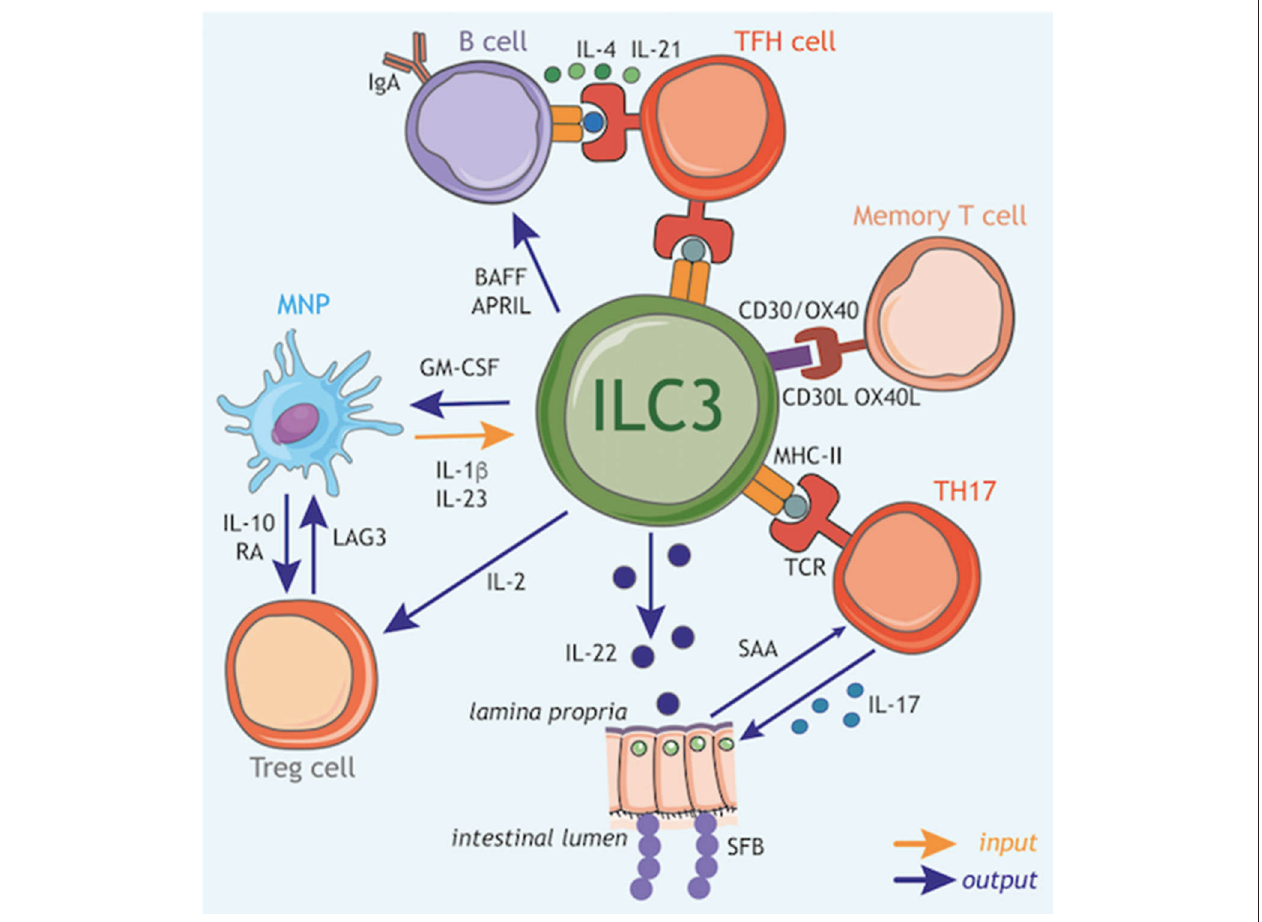
FIGURE 3 | ILC3 circuits orchestrate adaptive immune responses. In addition to their function as tissue-resident cytokine producing cells, ILC3s have the capacity to participate in multiple cellular circuits through direct cell–cell modulation of T cell responses, as well as the release of soluble mediators that augment adaptive immune function and development. ILC3s can control the magnitude and quality of the CD4 + T cell response via antigen presentation in the context of MHC class II (MHCII). At steady state ILC3s lack co-stimulatory molecule expression and appear to limit CD4 + T cell responses, however this interaction may be altered in inflammatory scenarios via upregulation of co-stimulatory molecules such as CD40, CD80, and CD86, which favor the promotion of T cell response. Furthermore, ILC3s act to modulate the survival of recirculating memory CD4 + T cells via interactions via OX40L and CD30L, although it is unknown whether this process also requires MHCII-dependent antigen presentation. In addition, ILC3 regulation of T follicular helper (TFH) cell responses has consequences for the priming of germinal center B cells and the induction of T-dependent IgA responses toward colon-dwelling commensal microbes. ILC3s can also modulate adaptive immune cells through the production of regulatory cytokines and growth factors. In line with this, ILC3 directly support B cell responses in the spleen through provision of critical growth factors such as BAFF/APRIL. Similarly, ILC3 also modulate the magnitude of the T cell response within the intestinal tract through the production of soluble mediators. For example, ILC3-derived IL-22 induces epithelial serum amyloid A (SAA) protein, which subsequently promotes local Th17 responses and acts to limit colonization with segmented filamentous bacteria (SFB) via the induction of antimicrobial peptides. In addition, ILC3 facilitate the establishment of a regulatory and tolerogenic environment in the gut by promoting regulatory T cell (Treg) responses. ILC3 crosstalk with tissue-resident myeloid cell populations establishes a feedback circuit whereby ILC3-derived GM-CSF promotes IL-10 and RA production by myeloid cells to promote Treg conversion. Conversely, Treg, myeloid cells and ILC3 may feedback on each other through a variety of soluble and cell-cell interactions suggesting a dynamic and malleable communication loop to ensure tolerance and tissue homeostasis. Finally, ILC3 subsets are a potent source of IL-2 in the small intestine that provides survival signals for Treg. Together these tissue-resident immune circuits place ILC3 at the center of a number of pathways through which they regulate adaptive immune responses to promote tissue health and homeostatic interactions with the